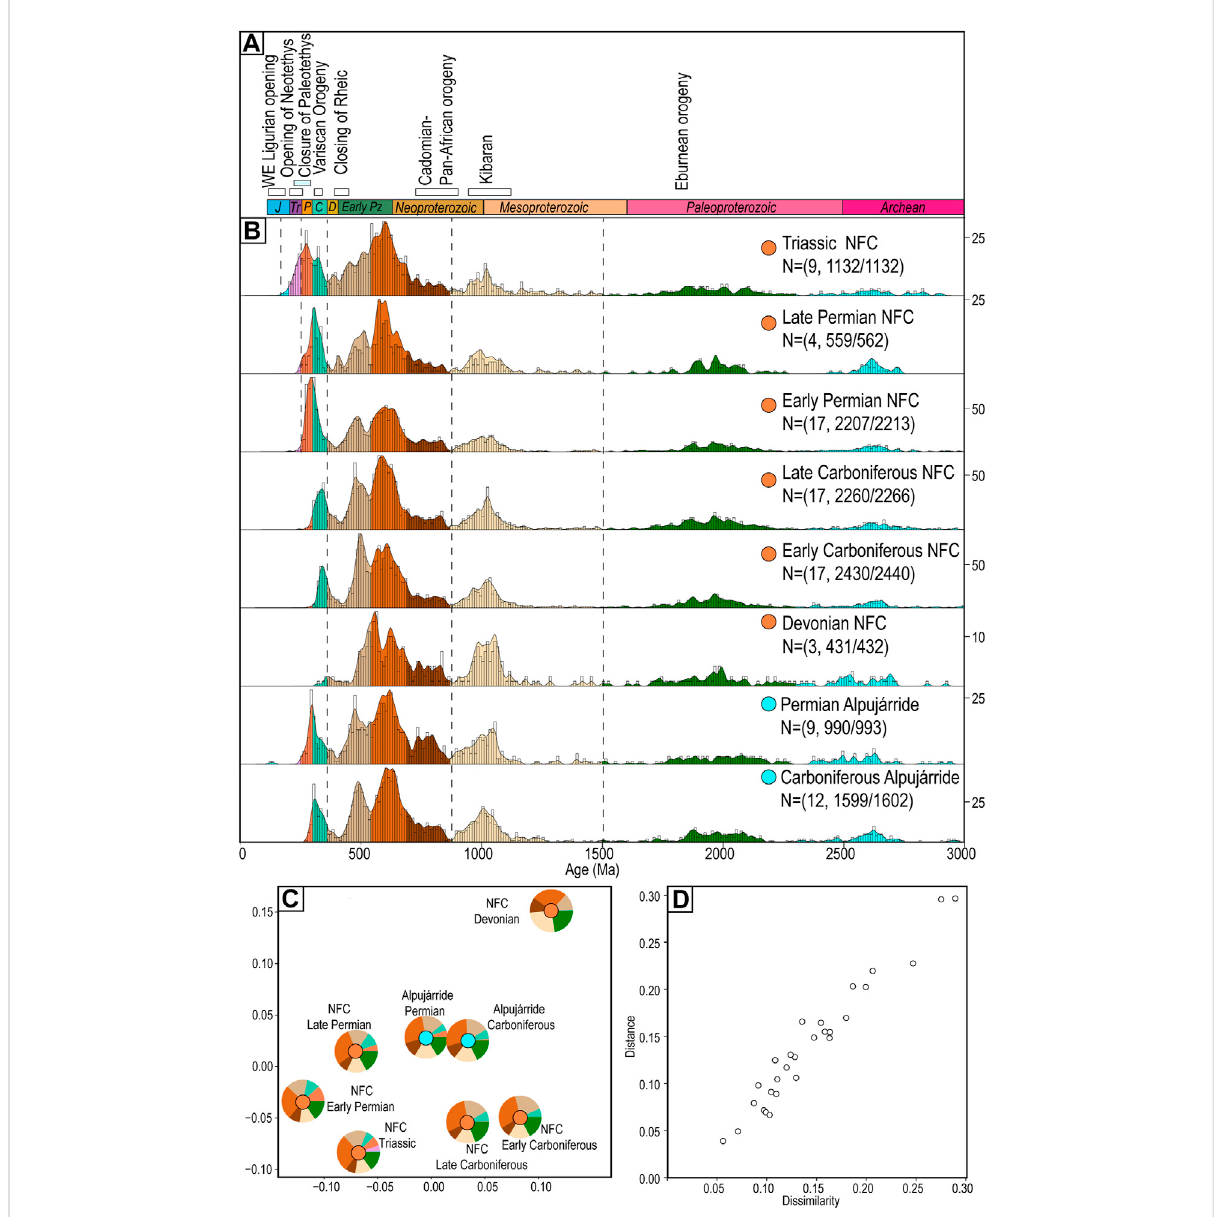
FIGURE 8 (A) Samples from theNFC and Alpujárrideplotted in KDEs represent multiplesamples grouped based on their extracted maximum depositional ages. Orange circles show NFC samples, while orange circles the Alpujárride samples. (B) Multi-dimensional space diagram showing similarity between NFC and Alpujárridespectragrouped by MDAs. (C) Shepard plot showing the goodness of best fi t for theMDS plot. Colors on KDEs and pie diagrams highlight the different age modes (light blue: Jurassic, pink: Triassic, orange: Permian, light green: Carboniferous, light brown: Early Paleozoic, burnt orange: Ediacaran, dark brown: Early Neoproterozoic, beige: Mesoproterozoic (1,000 – 1,600 Ma), green: Paleoproterozoic, and cyan: Archean). N = #/# shows the number of zircon grains appeared on the KDE space vs. analyzed and passed the discordance fi